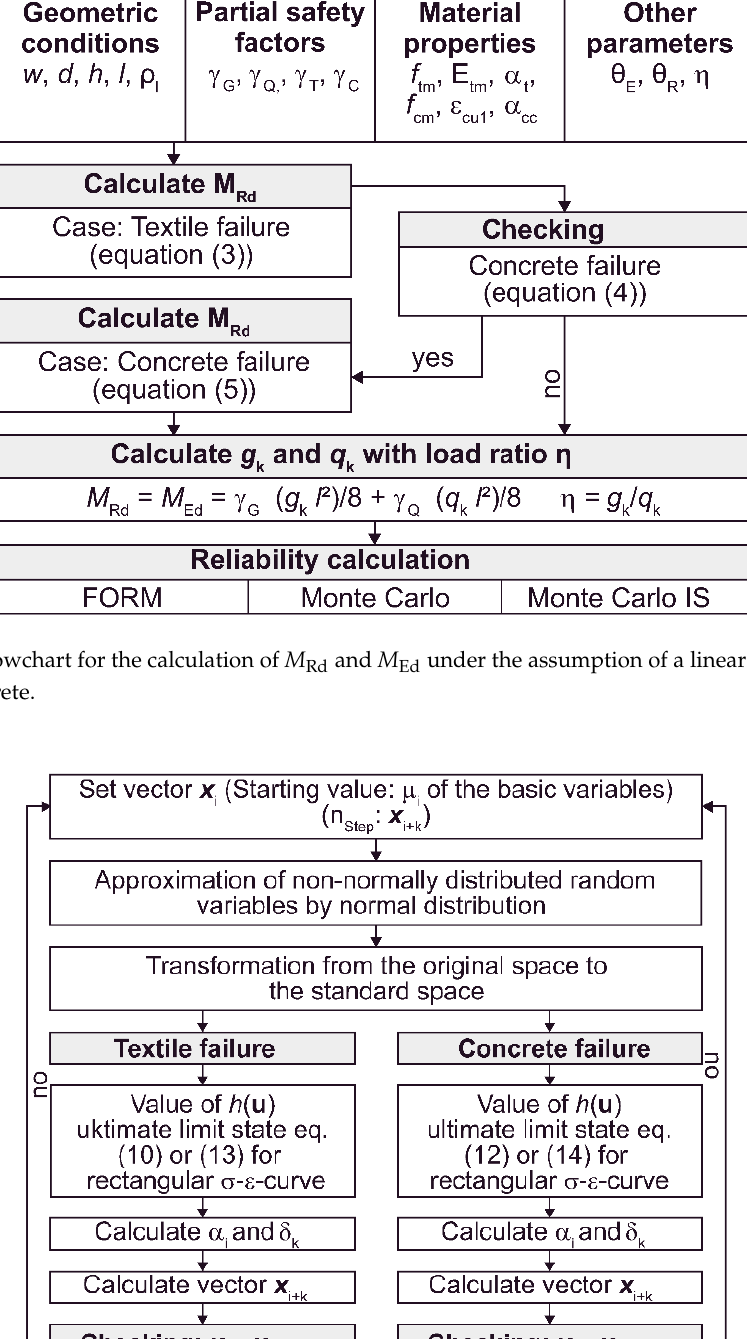
Figure 6. Flowchart for the calculation of the failure probability according to the Monte Carlo method. 5. Reliability Calculation Results 5.1. General Observations The reliability index β is given as a function of the reinforcement ratio ρ l and the effective depth d . The partial safety factors γ T vary between 1.0 and 1.5 so that the required safety level can be easily identified. To this end, the level at which these factors lead to a target reliability index β equal to 3.8 was determined, considering a reference period of 50 years.